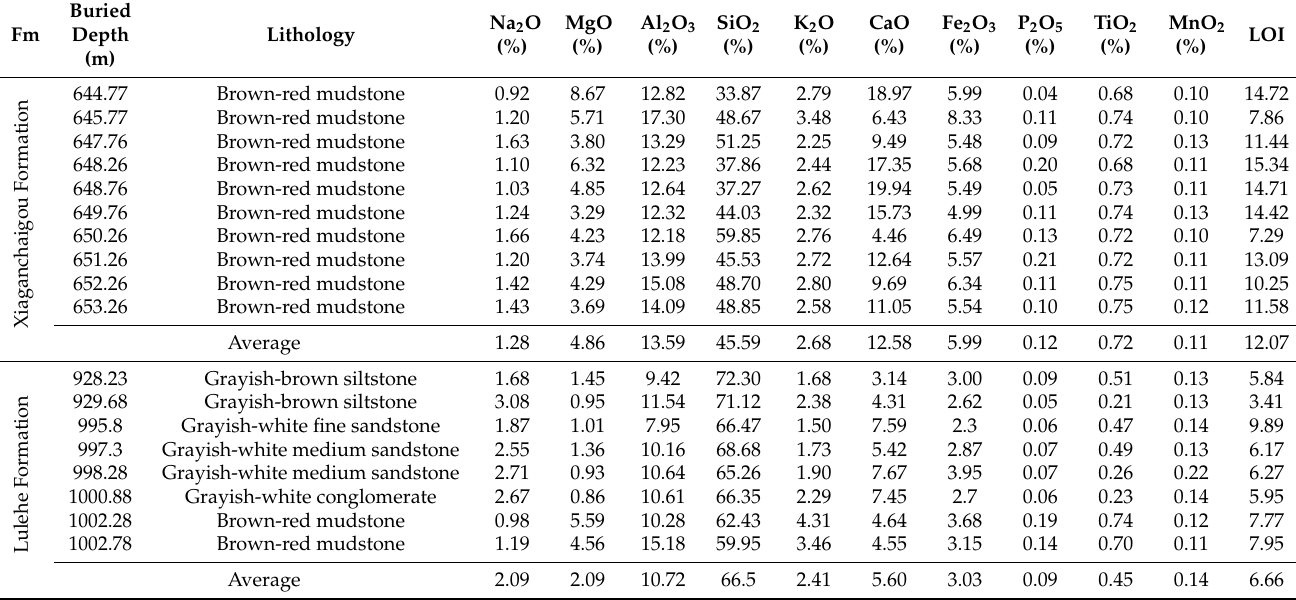
Table 2. Major oxide contents of the Eocene in the Pingtai